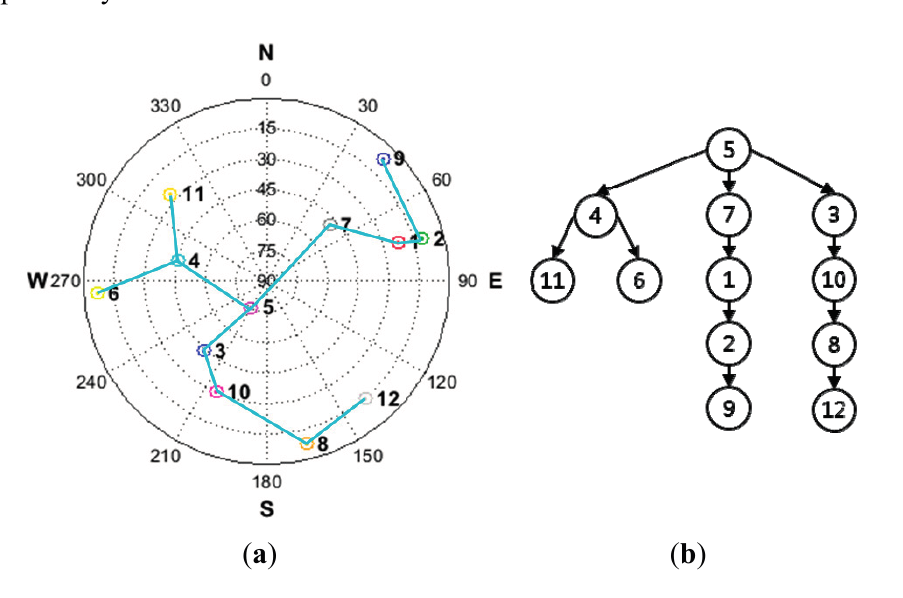
Figure 2. ( a ) Example satellite geometry; ( b ) resulting tree